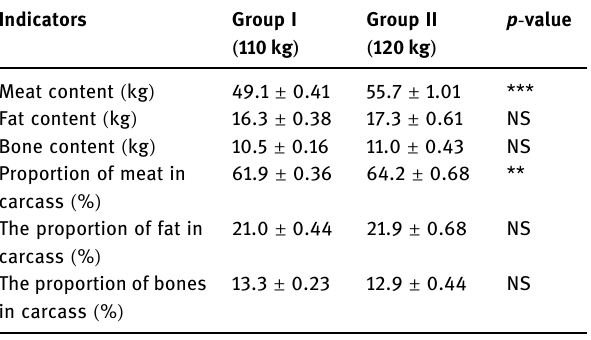
Table 5: Body composition of pig carcasses of experimental groups ( n = 60 )